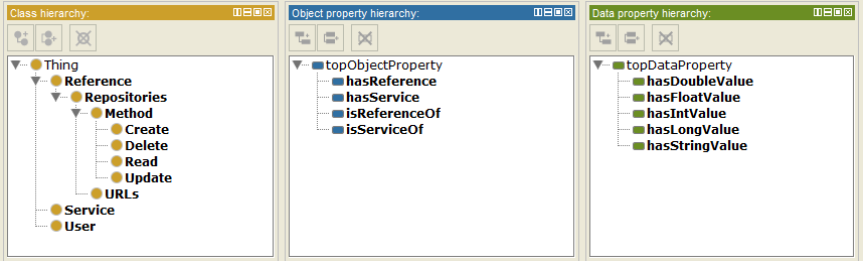
Figure 6. Hierarchy of classes, object properties, and data properties of the IIO: (from left), class hierarchy, object properties hierarchy, and data properties